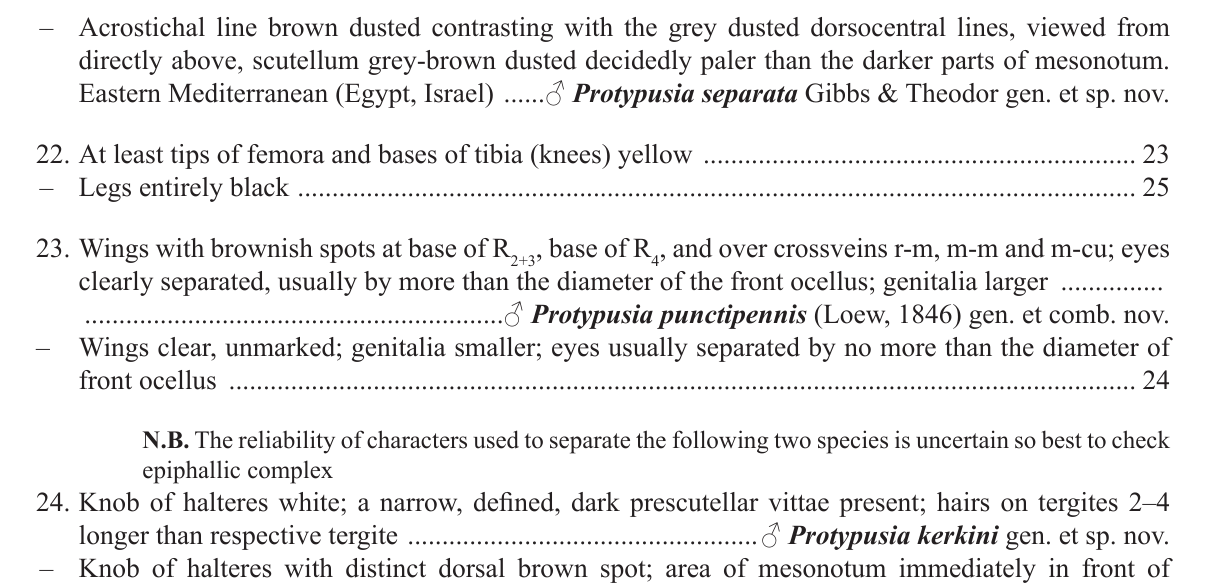
Acrostichal line brown dusted contrasting with the grey dusted dorsocentral lines, viewed from directly above, scutellum grey-brown dusted decidedly paler than the darker parts of mesonotum. Eastern Mediterranean (Egypt, Israel) ......♂ Protypusia separata Gibbs & Theodor gen. et sp. nov.